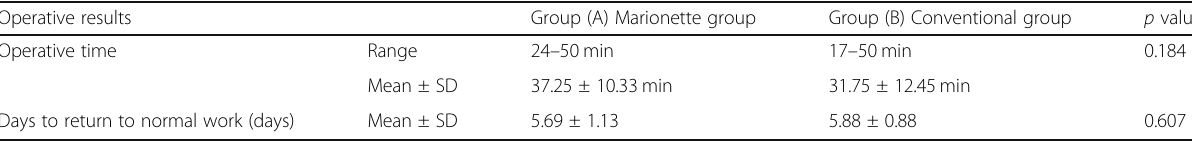
Table 3 Operative time and days to return to normal work Operative results